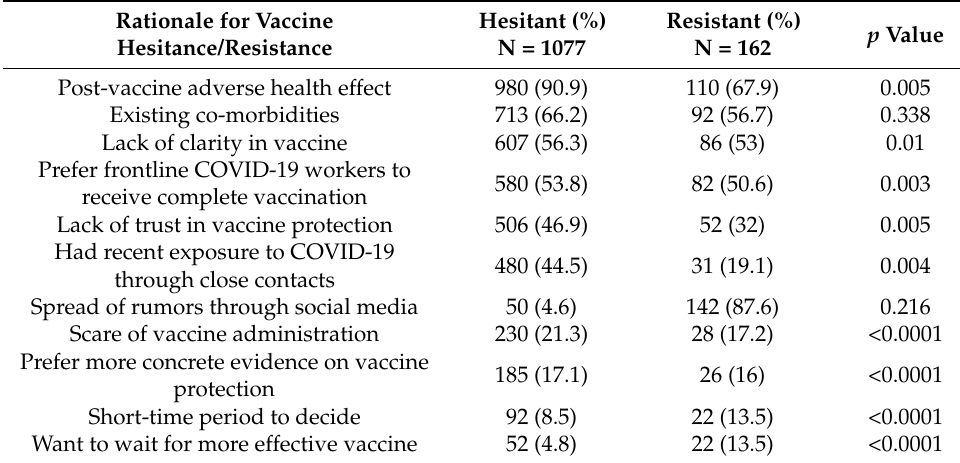
Table 2. Rationale for vaccine hesitancy and